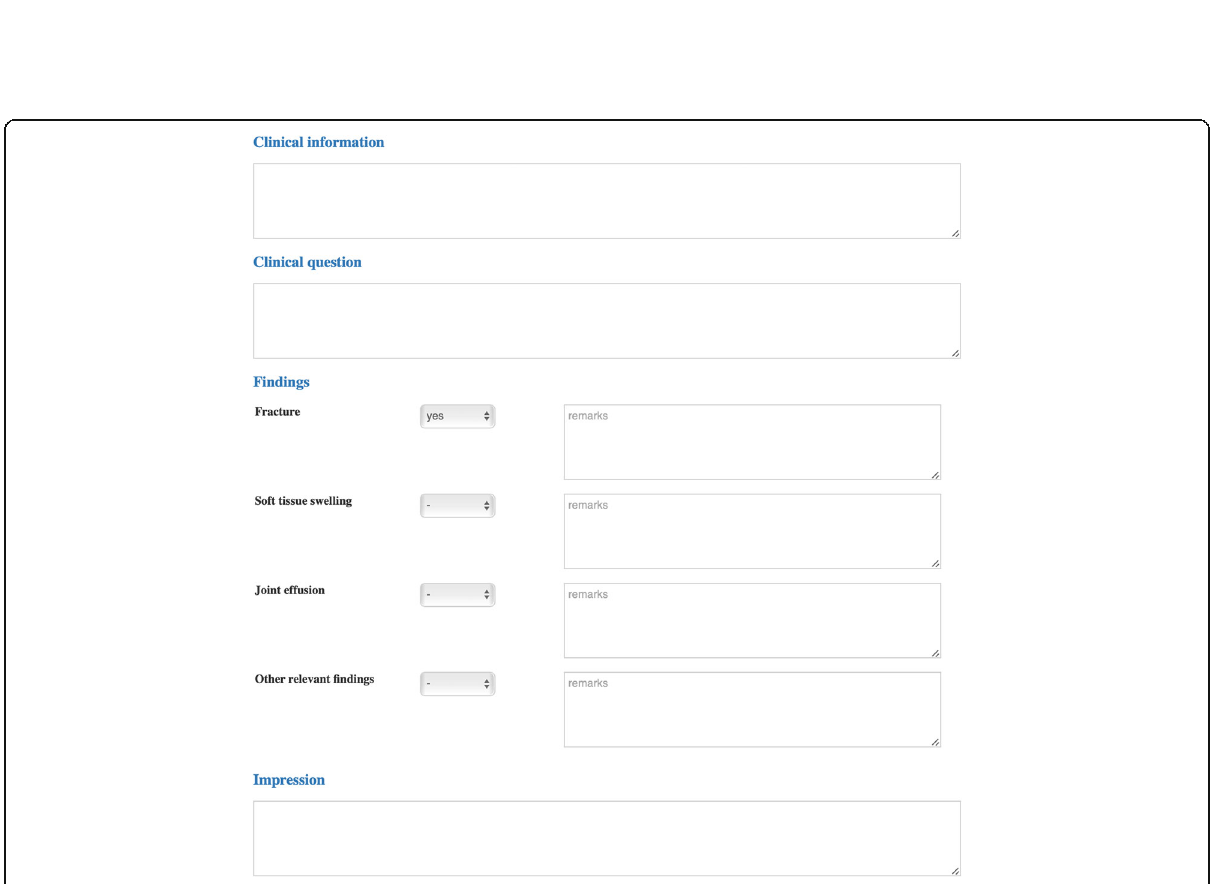
Fig. 2 Screenshot of the template used for structured reporting of ankle